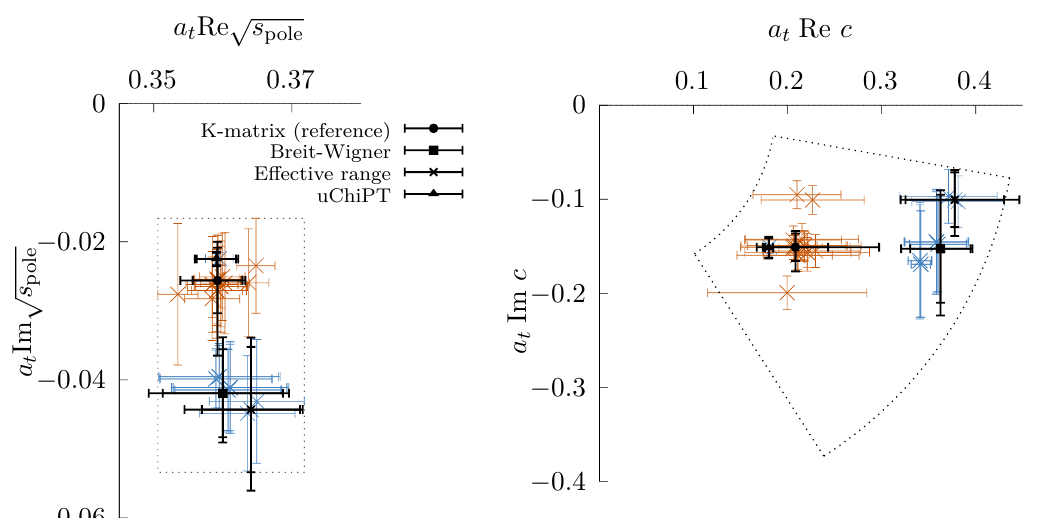
Figure 9. Poles on complex energy plane (left) and couplings (right). The black filled circle corresponds to the reference amplitude. Other amplitudes discussed in the text are shown with different markers (see key). The coloured datapoints in both panels show the spread of poles and couplings produced by the complete set of parameterisation variations (see tables 3 and 4). Or- ange crosshairs correspond to three-parameter S -wave amplitudes, blue crosshairs to two-parameter ones. The dotted rectangle encompasses the entire spread of the parameterisations including their statistical uncertainties, but excluding variations of mass or anisotropy for amplitudes other than the reference